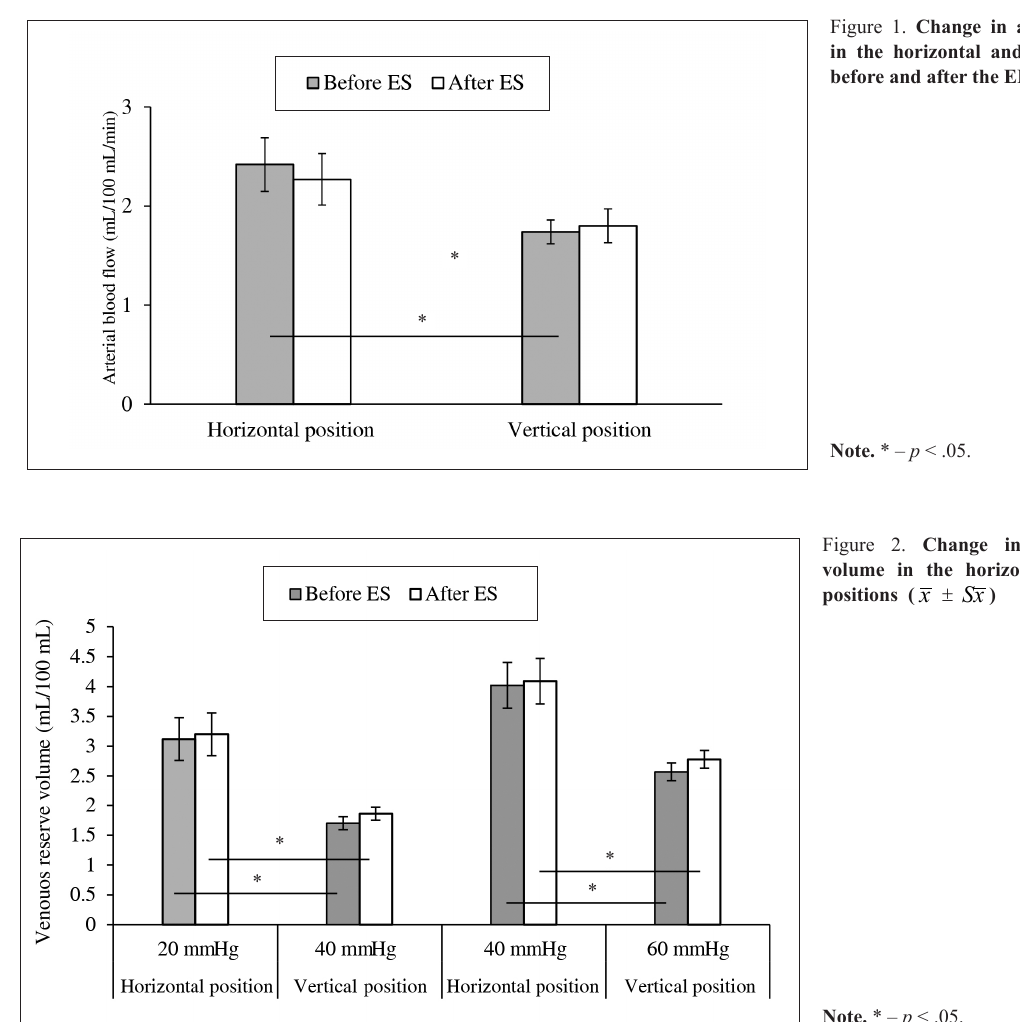
Figure 1. Change in arterial blood flow in the horizontal and vertical positions before and after the EMS ( x ± Sx )